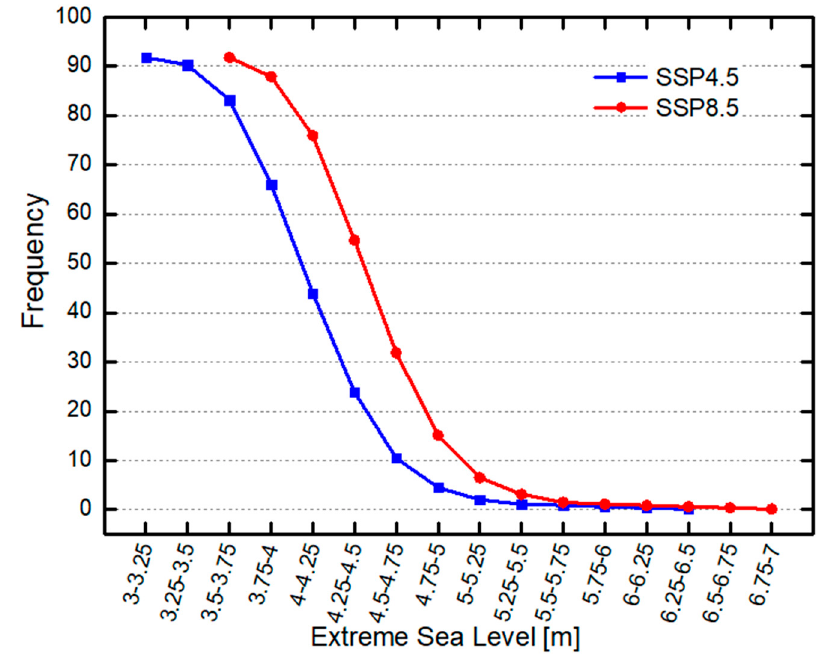
Figure 2. Estimated frequency of exceedance in 2080–2100.